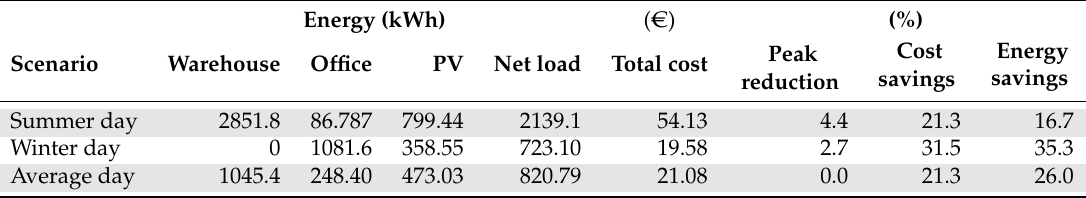
Table 9. Results for the energy minimization problem for three temperature scenarios in the Netherlands. Energy